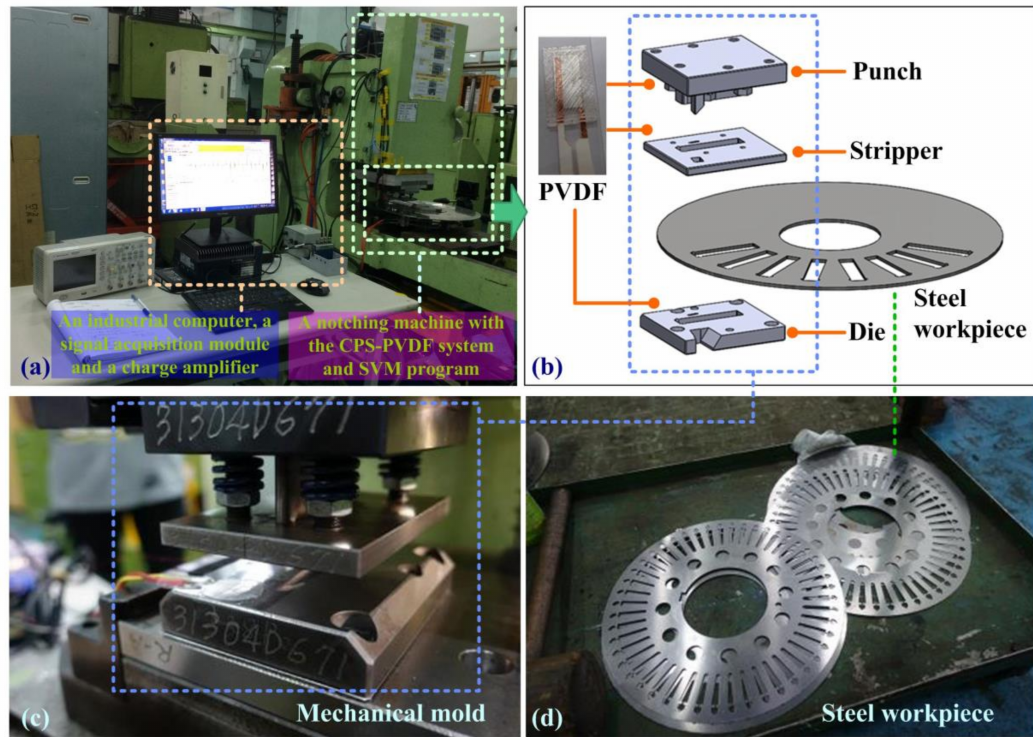
Figure 5. Experimental setup: ( a ) notching machine equipped with proposed PVDF film sensor; ( b ) practical setup of mechanical mold; ( c ) mechanical mold with embedded PVDF sensors and ( d ) completed